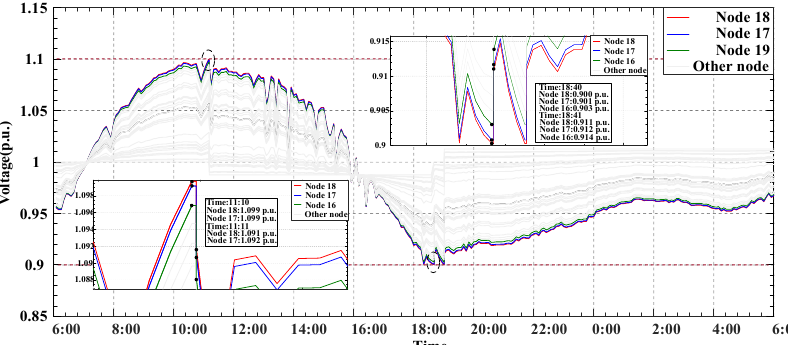
Figure 8. The voltage curves after regulating by the OLTC and ACs.